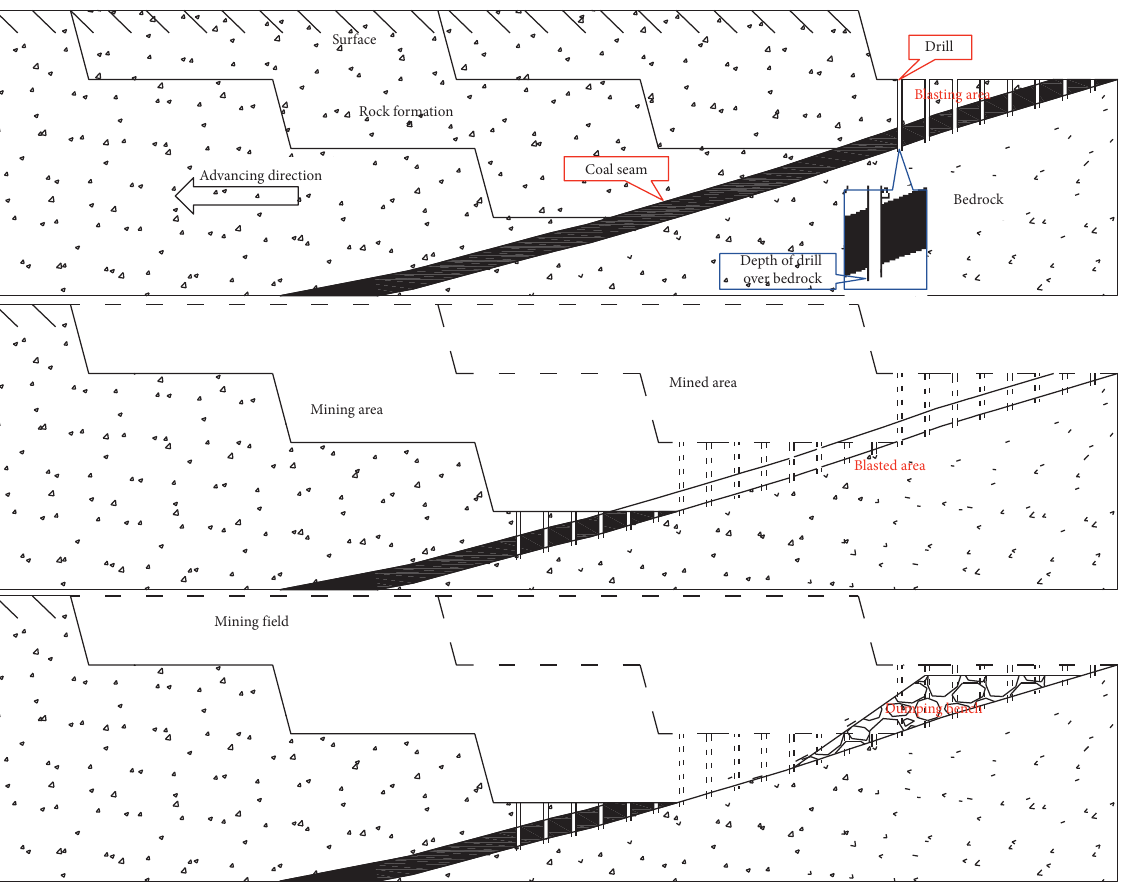
Figure 2: Bumpy surface